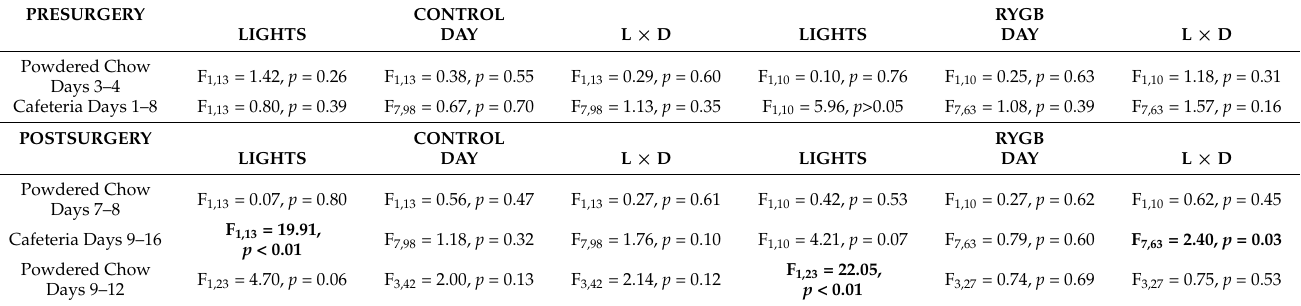
Table 21. Two-way ANOVAs Comparing Lights-On to Lights-Off Intermeal Intervals within Groups for Each Diet Condition.